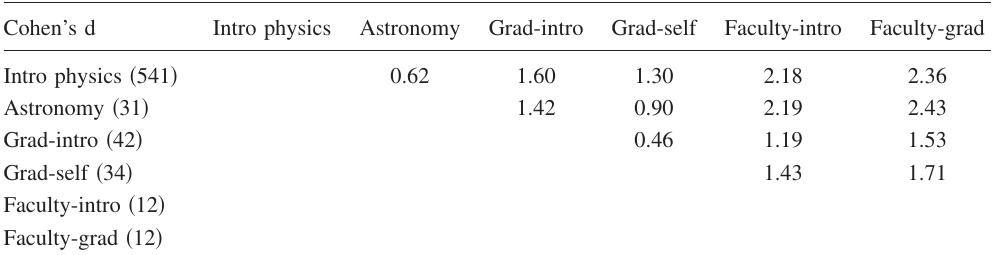
TABLE II. Effect sizes between two groups. The number of people in each group is given in the parenthesis. All effect sizes are positive because they are always taken such that (cid:4) 2 (cid:3)(cid:4) 1 in the calculations (cid:1) i.e., subtracting the higher mean from the lower mean; see Table I (cid:2) . ANOVA using Pairwise t -test shows that the differences between all the groups is significant except that between faculty members for introductory- level and graduate-level problem solving (cid:1) p =0.269 for that case (cid:2) . Therefore, Cohen’s d was not calculated for Faculty-intro vs. faculty-grad.